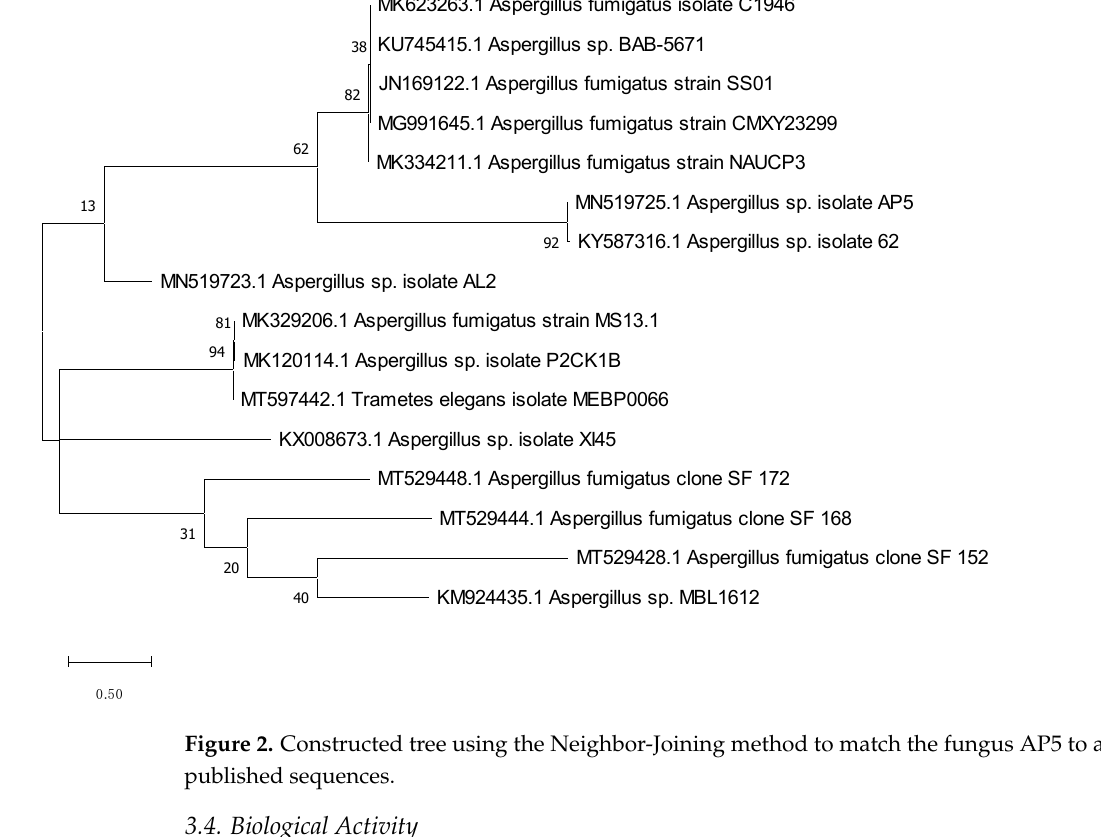
Figure 2. Constructed tree using the Neighbor-Joining method to match the fungus AP5 to already published sequences.